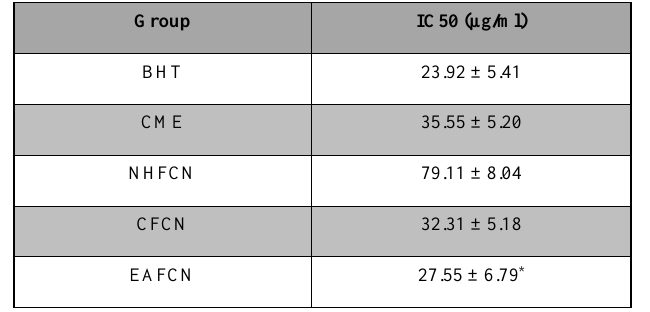
Table 4. Antioxidative potentials of different fractions of Cocos Nucifera extracts.